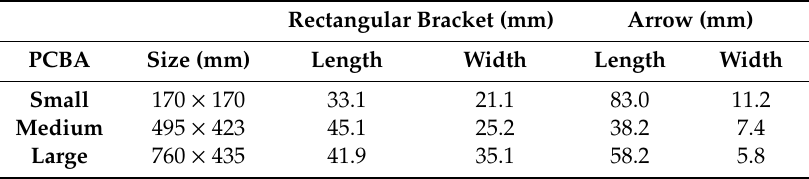
Table 5. Rectangular Bracket and Arrow Dimensions.